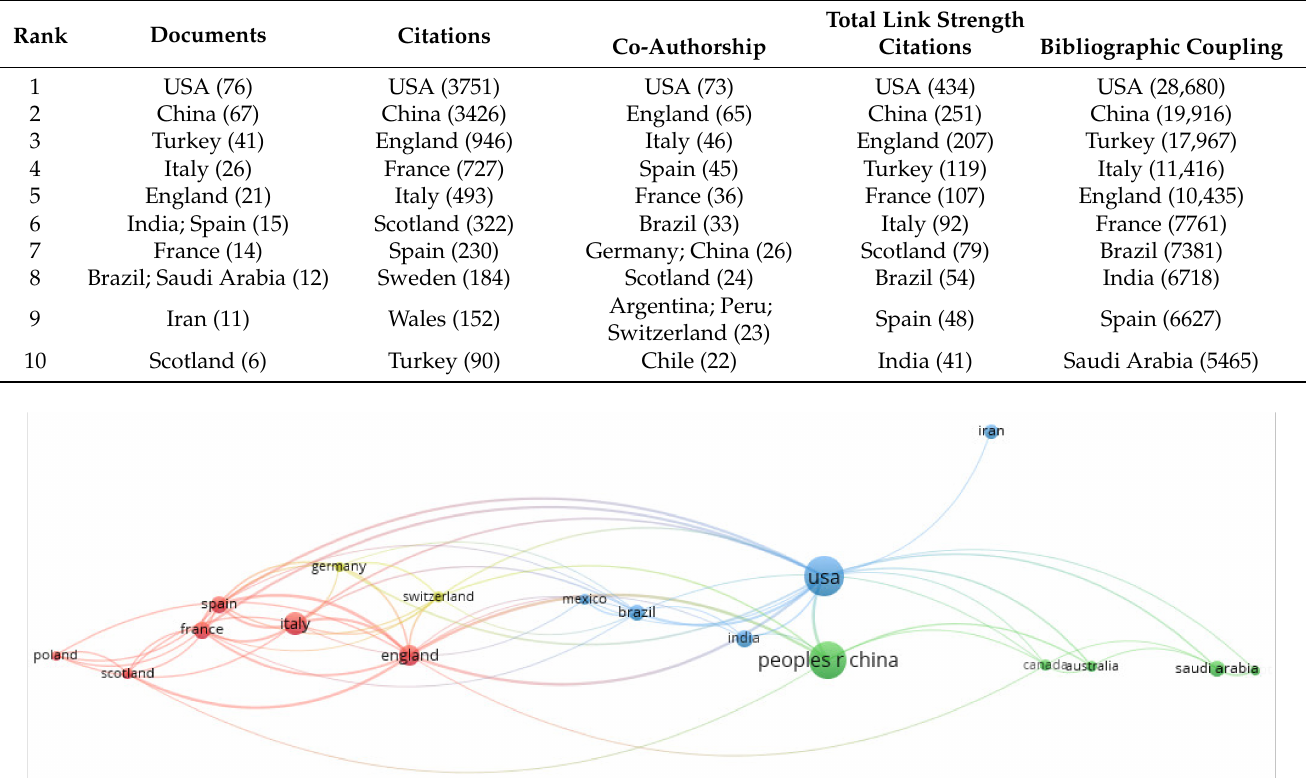
Figure 3. VOSviewer network visualization map of countries (type of analysis: co-authorship, weights—documents, minimum number of documents of a country—5, 19 countries meet the thresh- old, largest set of connected items—18 countries—Turkey meets the threshold (5 documents) but is not connected with other countries).